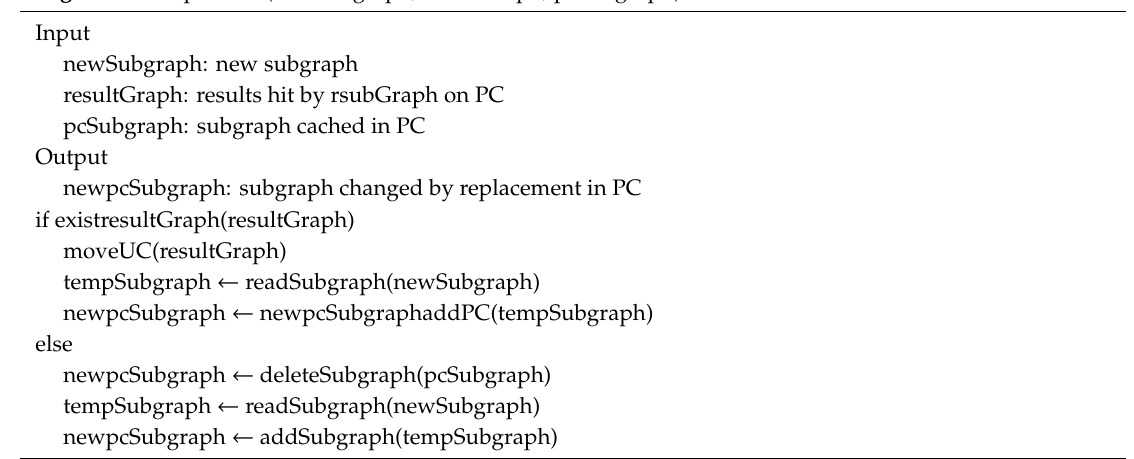
Algorithm 3 replacePC(newSubgraph, resultGraph,